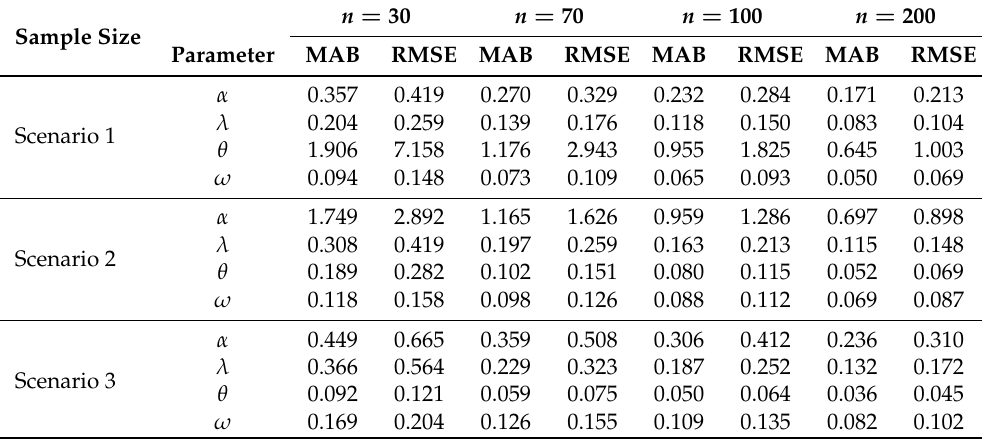
Table 2. Simulation results, based on 5000 replications, to evaluate the EM algorithm under three